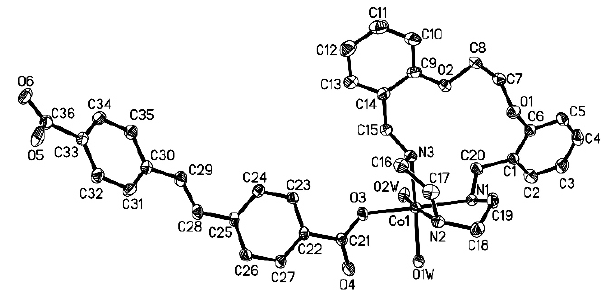
Table 2. Atomic coordinates and displacement parameters (in Å 2 )